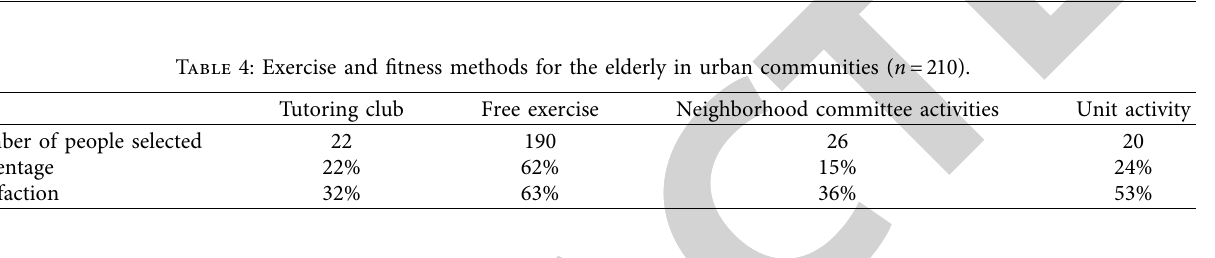
Table 5: Exercise and fitness time for the elderly in urban com- munities ( n � 210).